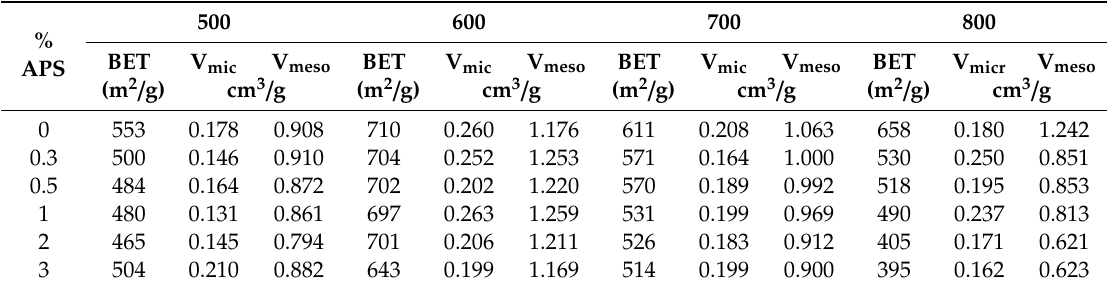
Figure 2. ( a ) Thermogravimetric and ( b ) di ff erential scanning calorimetry curves of the materials pyrolyzed at di ff erent temperatures and containing 1% γ -APS in solution (the contribution to the non-functionalized substrate has been subtracted to the thermogrammes). Table 1. Specific surface area (as determined by BET), micropore (as determined by the t-plot method) and mesopore volume (determined from BJH method) of the prepared